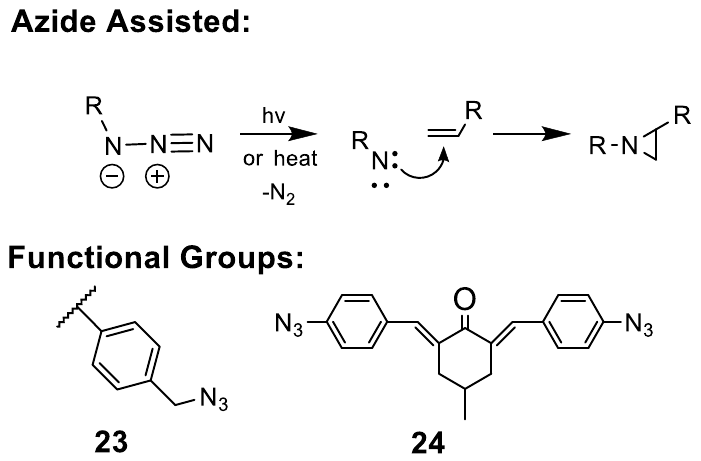
Figure 14. Azide-assisted crosslinking and functional monomers used.